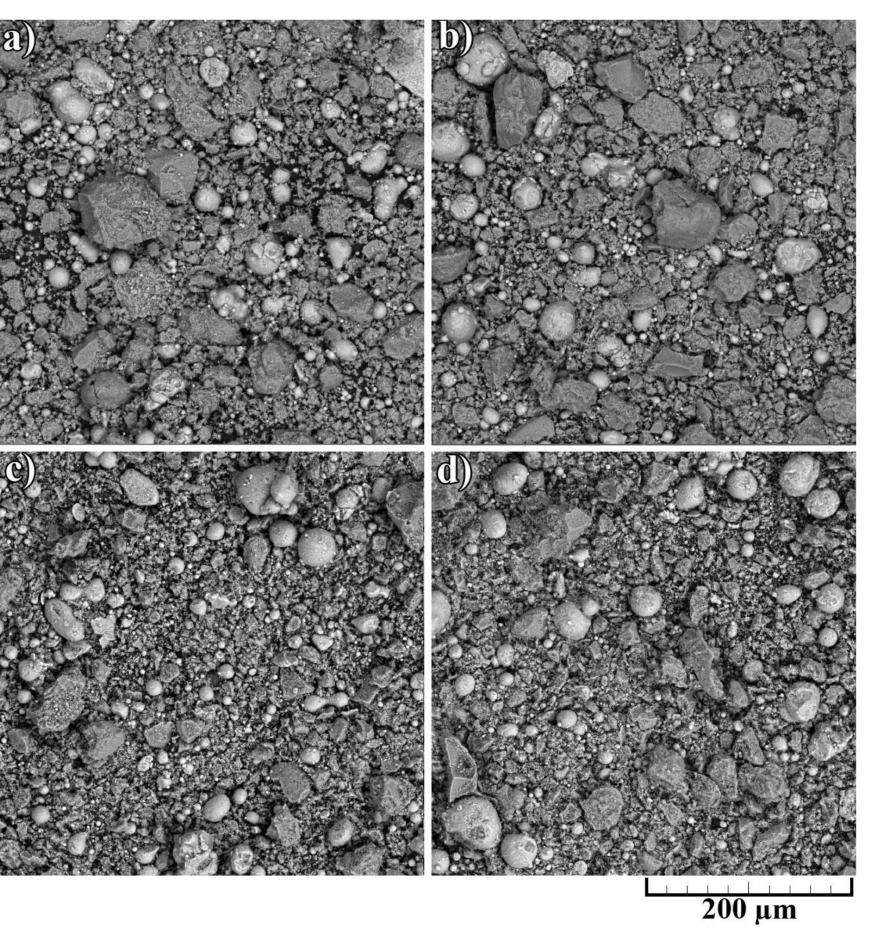
Figure 4. Morphology of composite powders after mixing: ( a ) 30% Al + 70% Al 2 O 3 ; ( b ) 29.5% Al +